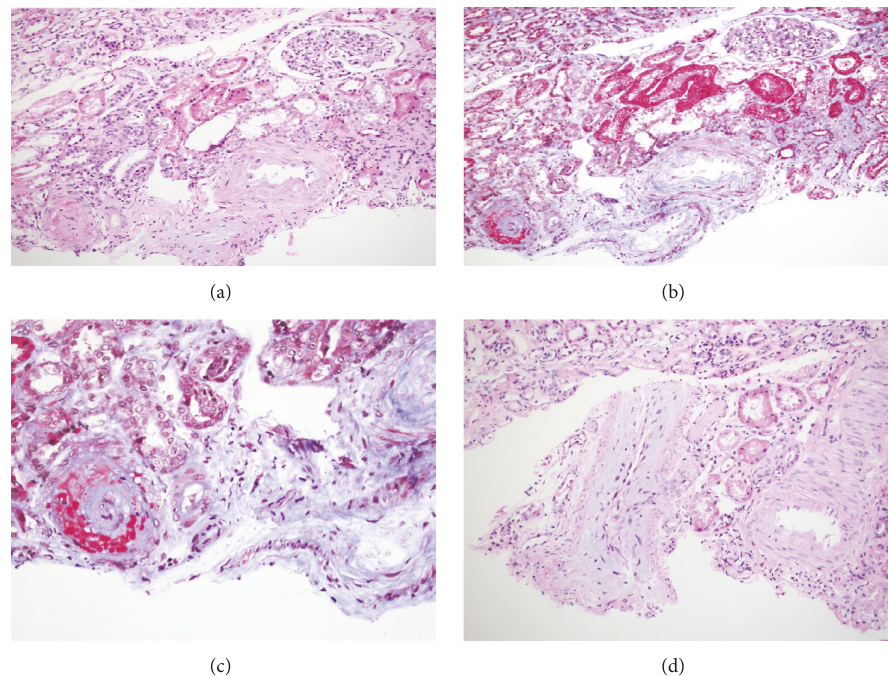
Figure 1: Renal parenchyma with glomerular ischemia. ((a) Hematoxylin y Eosin 10X, (b) Trichrome 10X), associated with vascular changes in interlobular arteries: fibrinoid necrosis of the intima with fragmentation of erythrocytes, ((c) Tricromico 20X) and mucoid expansion of the intima with luminal obliteration, and ((d) haematoxylin and eosin 10X).